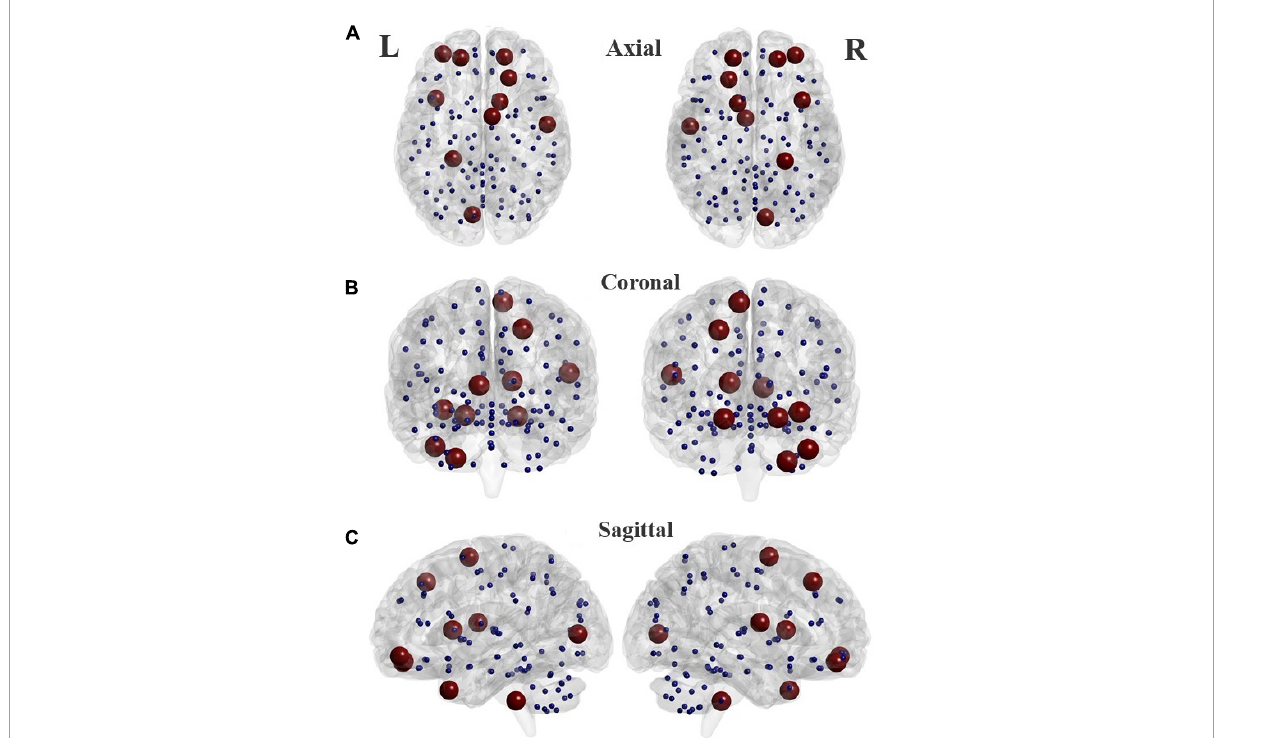
FIGURE5 Locations of the brain regions in the AAL atlas (listed in Table 4 ) that present highest discrimination ability between TD and ADHD groups in different planes. Axial (A) , Coronal (B) , and Sagittal (C) .